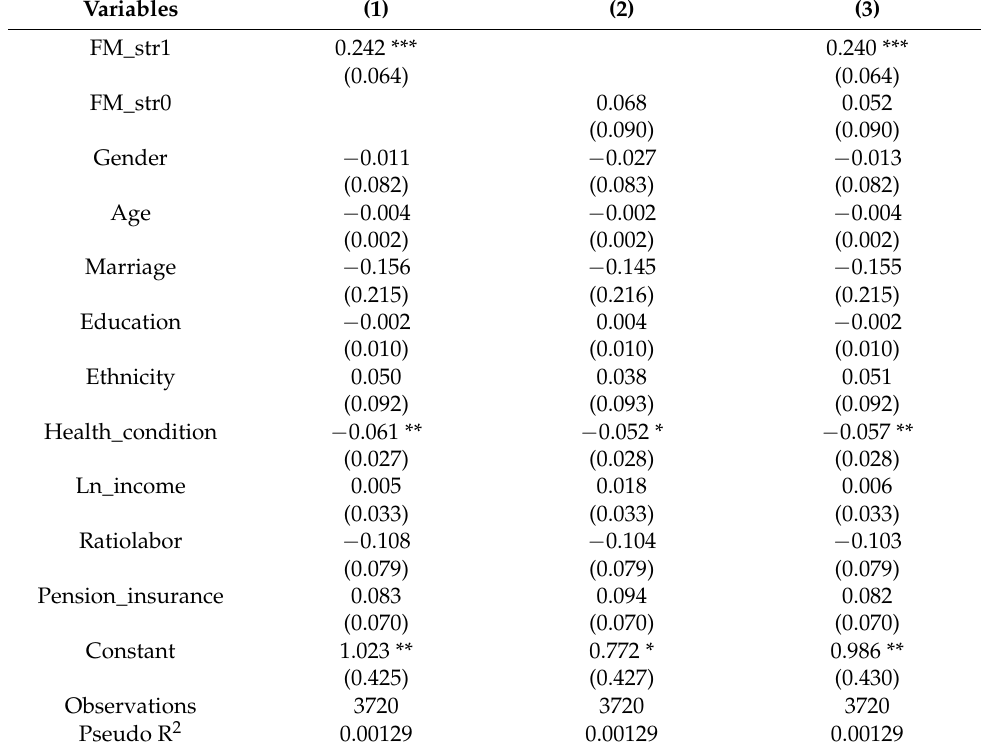
Table 2. Benchmark regression